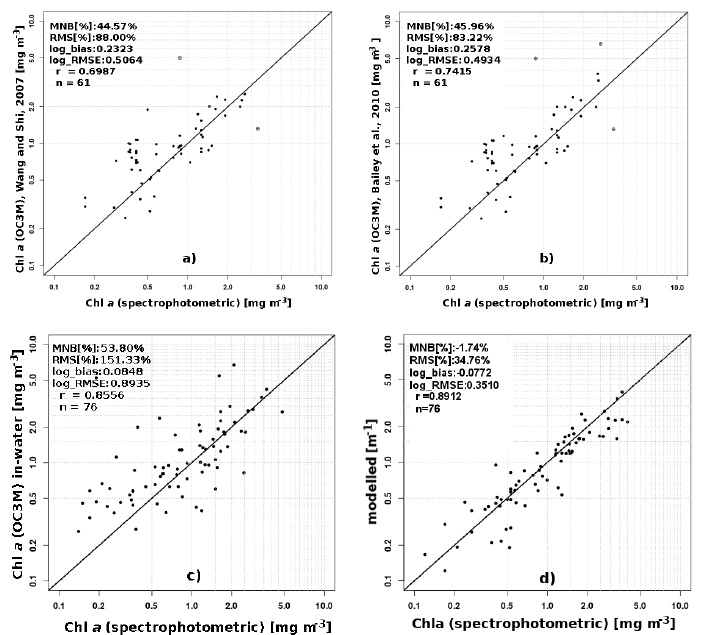
Figure 8. Scatterplots of predicted chlorophyll a concentration against spectrophotometric chlorophyll a concentration measurements: ( a ) satellite OC3M algorithm (MODIS AQUA) with the Wang and Shi (2007) [62] atmospheric correction applied, ( b ) satellite OC3M algorithm (MODIS AQUA) with the Bailey et al. (2010) [61] atmospheric correction applied ( c ) OC3M algorithm computed from in-water radiometric measurements using reconstructed MODIS bands, ( d ) proposed